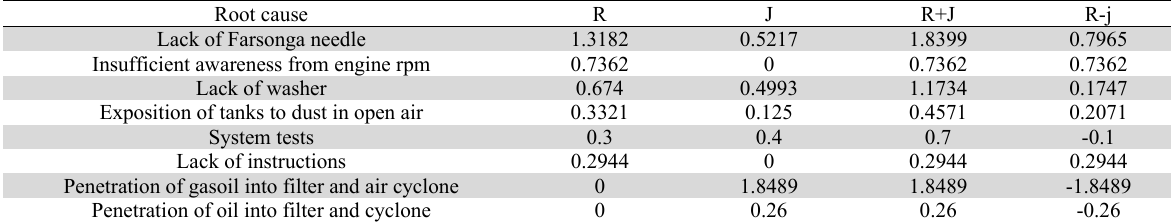
Pattern of causative